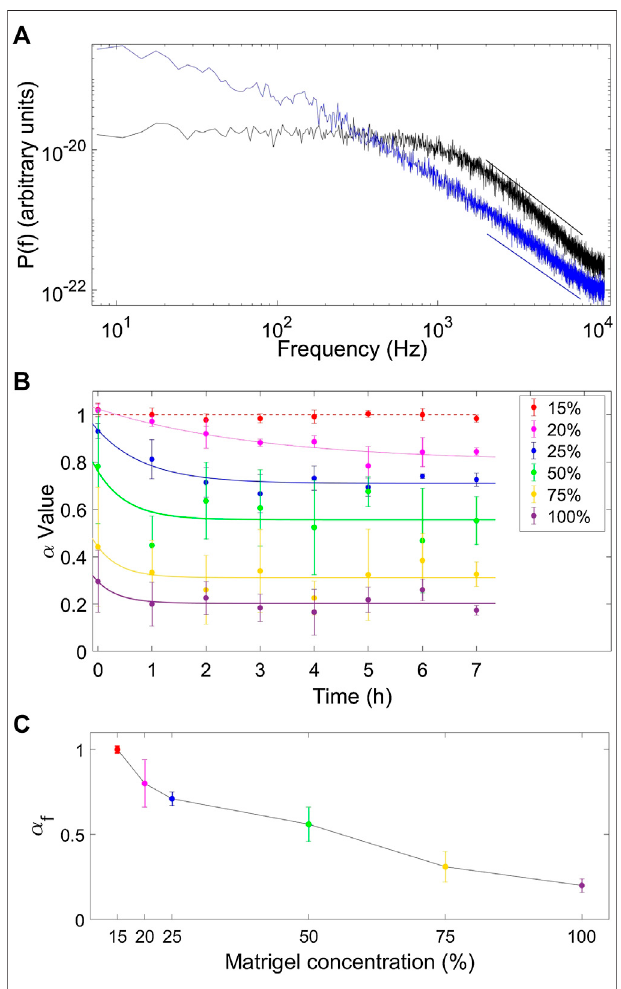
FIGURE 2 | Determination of scaling properties and evaluation of how these change as a function of time and concentration. (A) Power spectrum of an optically trapped particle in water (black, α (cid:1) 1) and in a Matrigel mixture (ratio75%medium to25%matrigel)(blue, α (cid:1) 0.71)7 hafterpreparation ofthesample.Thestraightlines show fi tsof Eq.2 todata, fi tswerecarried out on data blocked as described in refs. 38 and 39. (B) Values of α as a function time for tracer particles embedded in different concentrations of matrigel solution (15% red, 20% magenta, 25% blue, 50% green, 75% orange, and pure Matrigel solution (100%) purple). Solid lines show exponential fi ts to the experimental data which indicate that α reachesan asymptotic value, α f , after a few hours. (C) The value of α f decreases with Matrigel concentration: α f (cid:1) 1 . 00 ± 0 . 02 for 15% Matrigel, α f (cid:1) 0 . 80 ± 0 . 14 for 20% Matrigel,